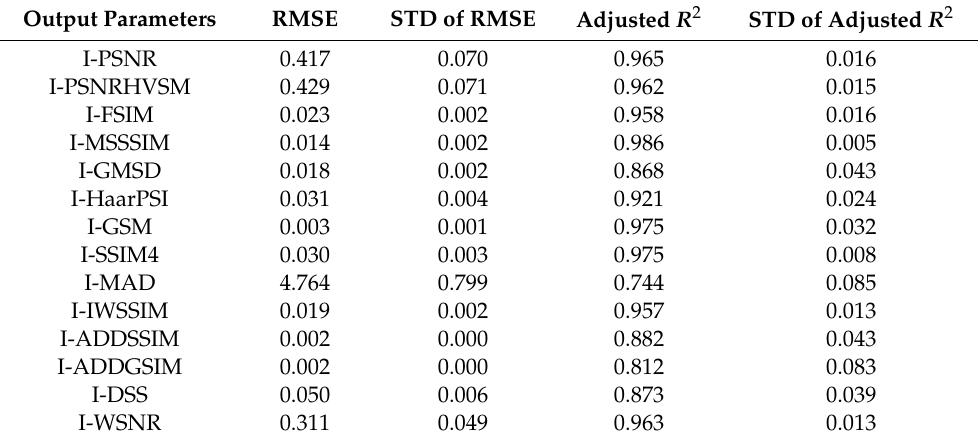
Table 6. Cross-dataset evaluation using another channel (#